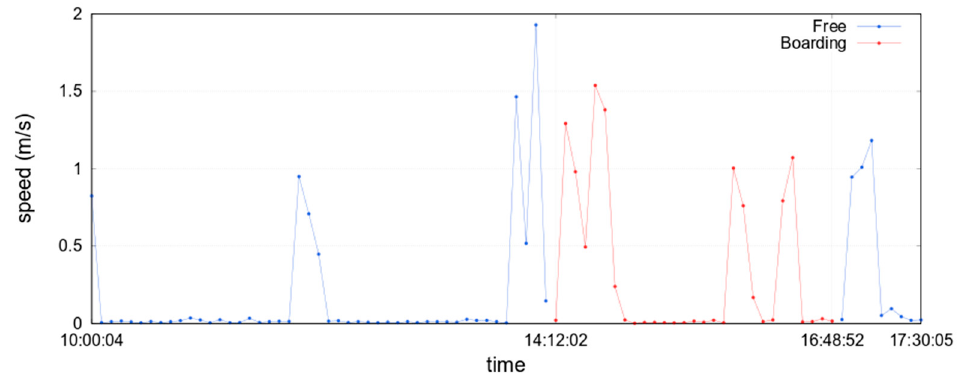
Figure 3. Typical example of time evolution of rickshaw velocity, based on raw data shown in Table 1: speed or velocity is calculated by assuming paths with straight line distance between two sequential pair values of longitude and latitude.